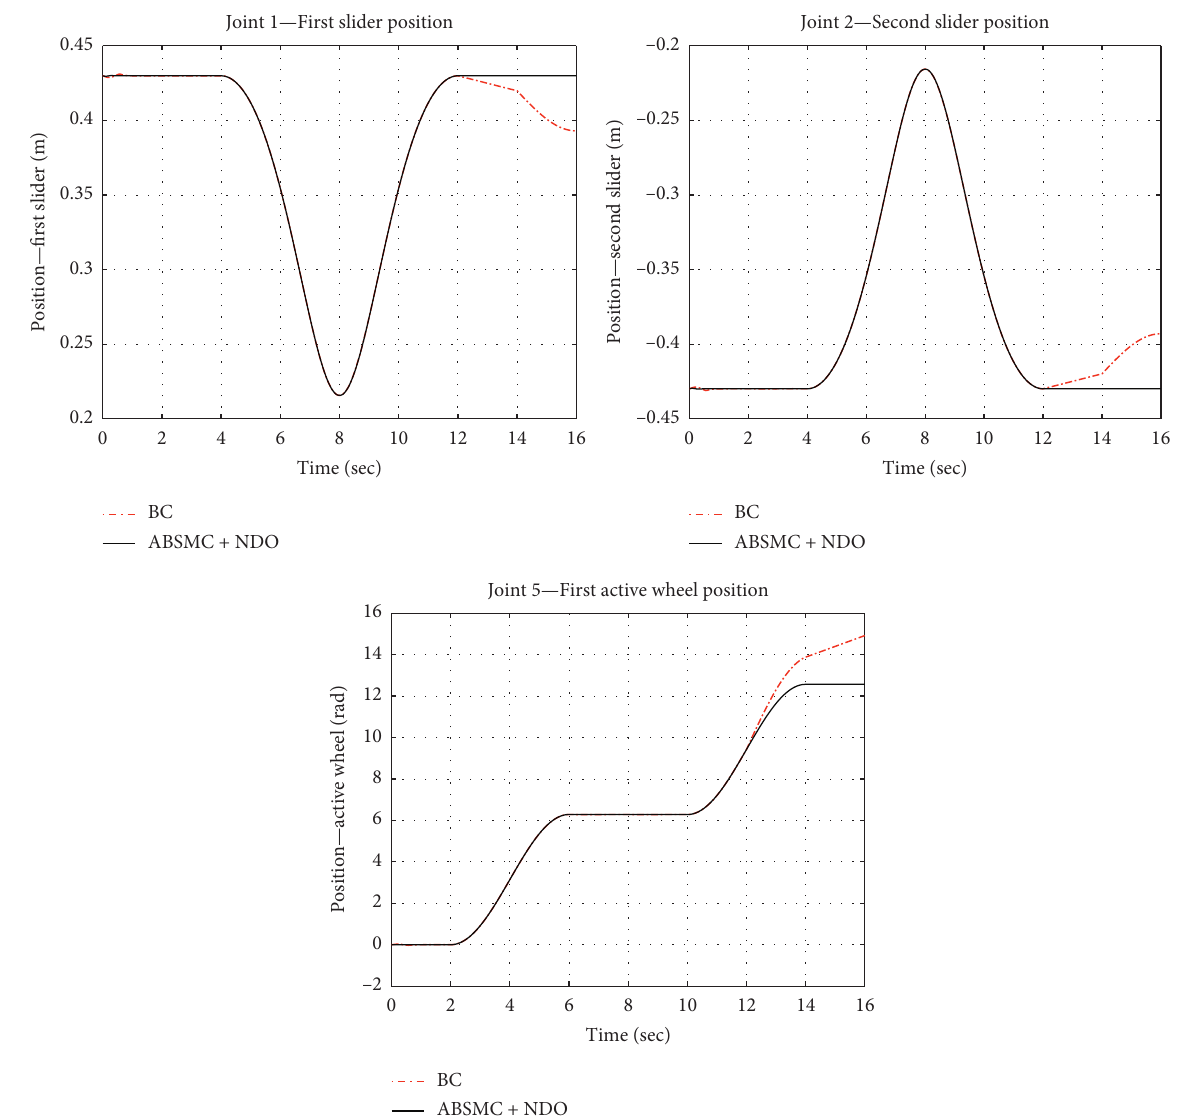
Figure 3: Each joint position tracking